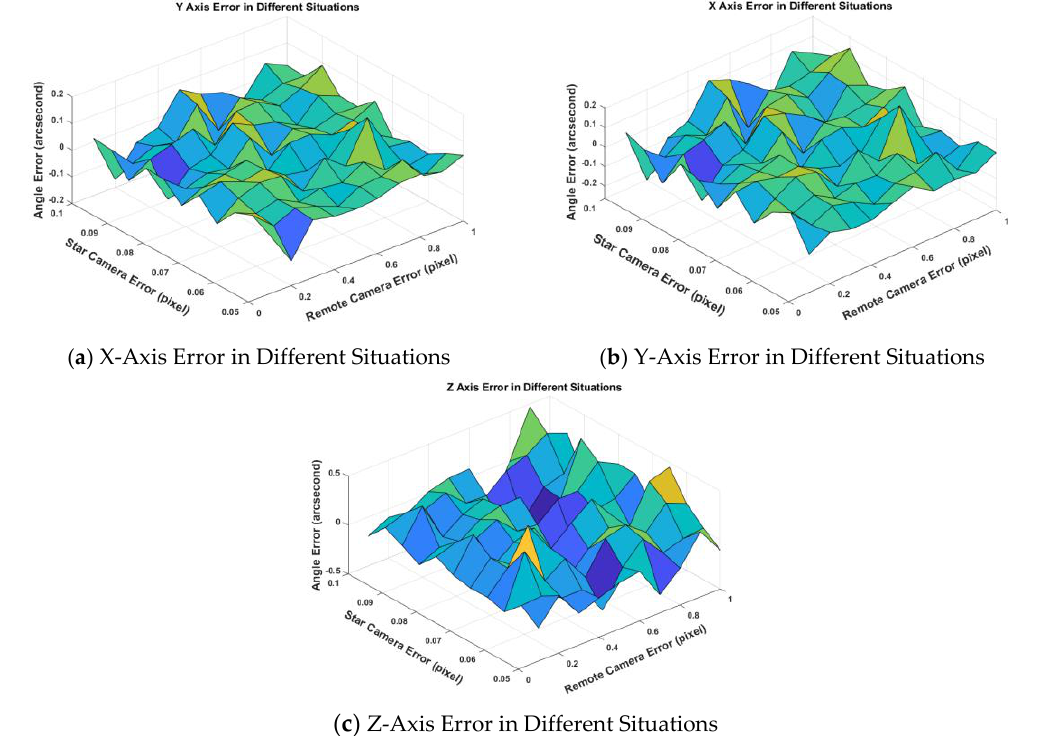
Figure 7. Triaxial deviation angle of calculated installation matrix under different errors of the star camera and remote sensing camera by using this paper algorithm. The unit of centroiding error is pixel for X and Y -axis and arc-second for Z -axis.